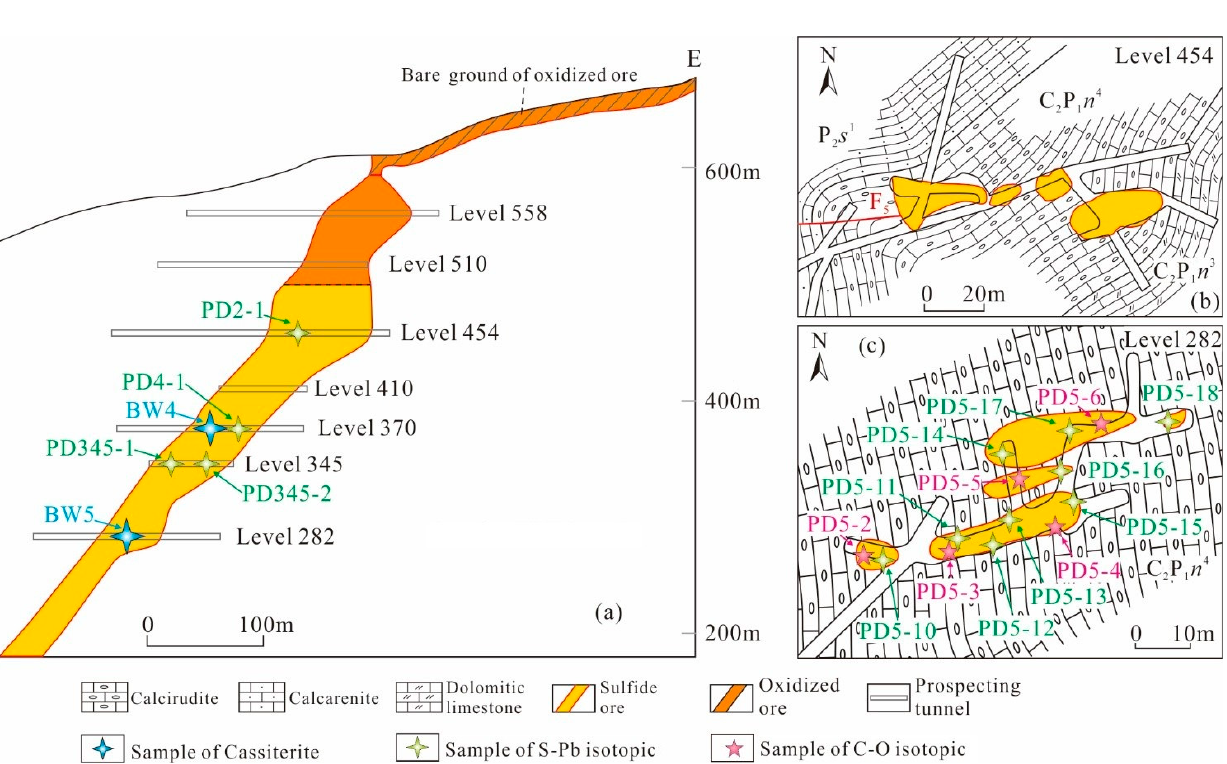
5 of 19 Figure 2. Geological sketch map ( a ) and ore-controlling structural styles ( b , c ) of the Bawang deposit. The strata in the Bawang deposit are monocline (Figure 2b). The strike of the strata is nearly SN and NNW, the dip direction ranges from 240° to 290°, and the dip angle is mostly 35° ~ 60°. The fault structure is generally developed, trending N–S, E–W, and NW– SE. The F 3 fault is located in the middle of the mining area, in which three tin–zinc ore bodies (II-1, II-2, II-3) occur (Figure 2c). It is a S–N trending tensional normal fault with a length of about 1 km, dip direction of 260° ~ 280°, and dip angle of 55°–66°. The F 5 fault is located in the north–central mining area, hosting I ore body. This fault is a zone formed by a series of overlapping dense fractures (joints) striking NEE–NE, with SSE–SE dipping